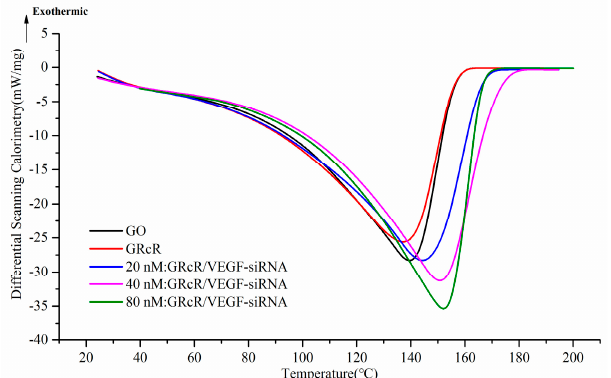
Figure 6. Differential scanning calorimeter (DSC) spectra of GO (black), GRcR (red), and GRcR loaded with different concentrations of VEGF-siRNA (20, 40 and 80 nM).